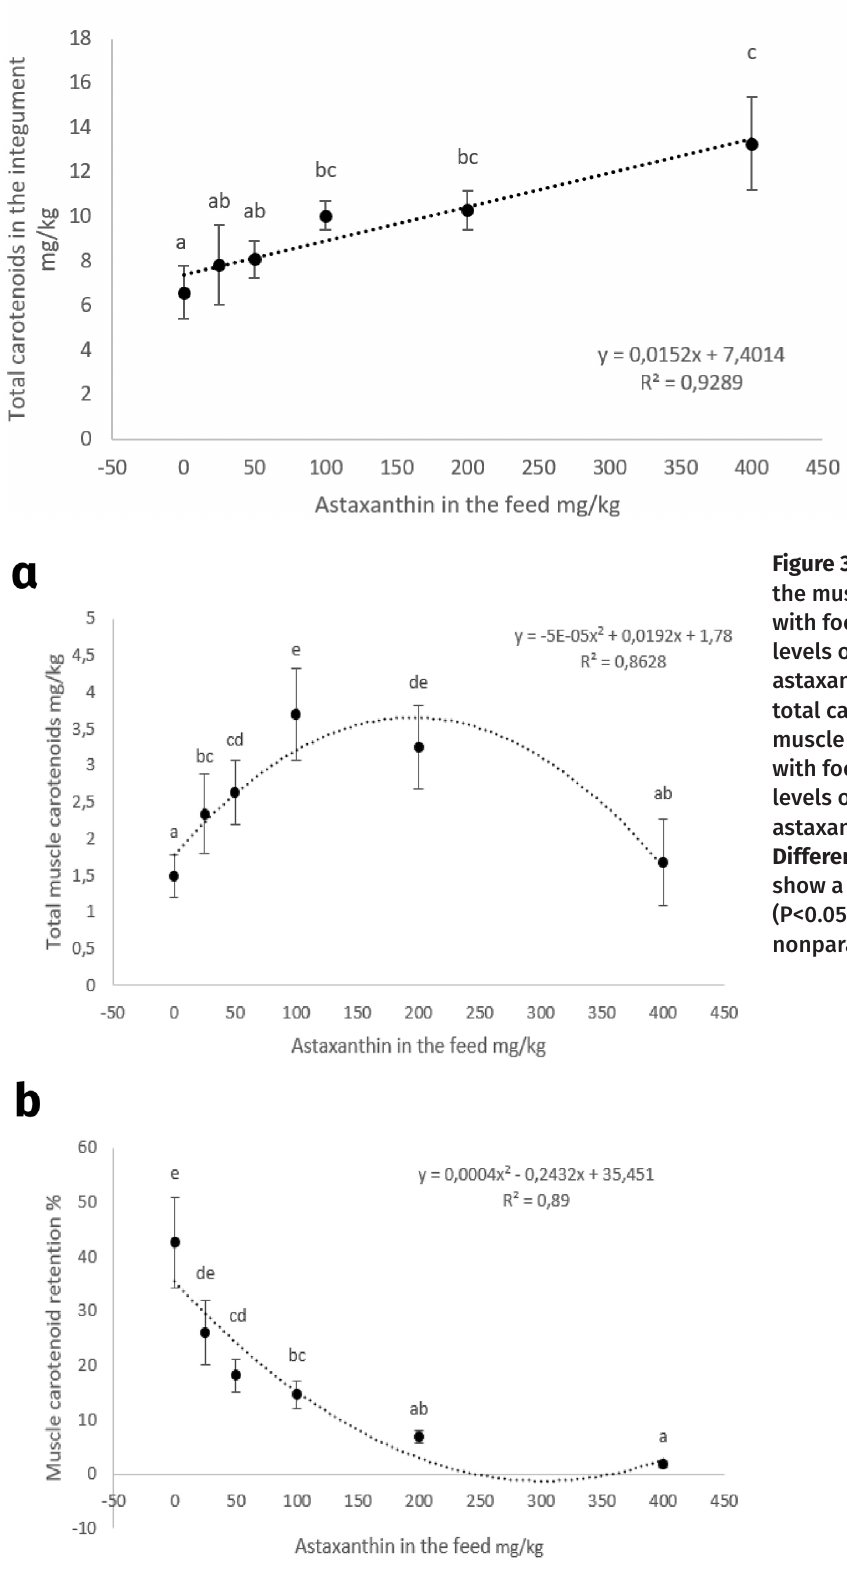
Figure 2. Total carotenoids in the integument of L. alexandri fed with ration containing different levels of inclusion of synthetic astaxanthin. Different letters show a significant difference (P<0.05) by the Kruskal - Wallis nonparametric test.